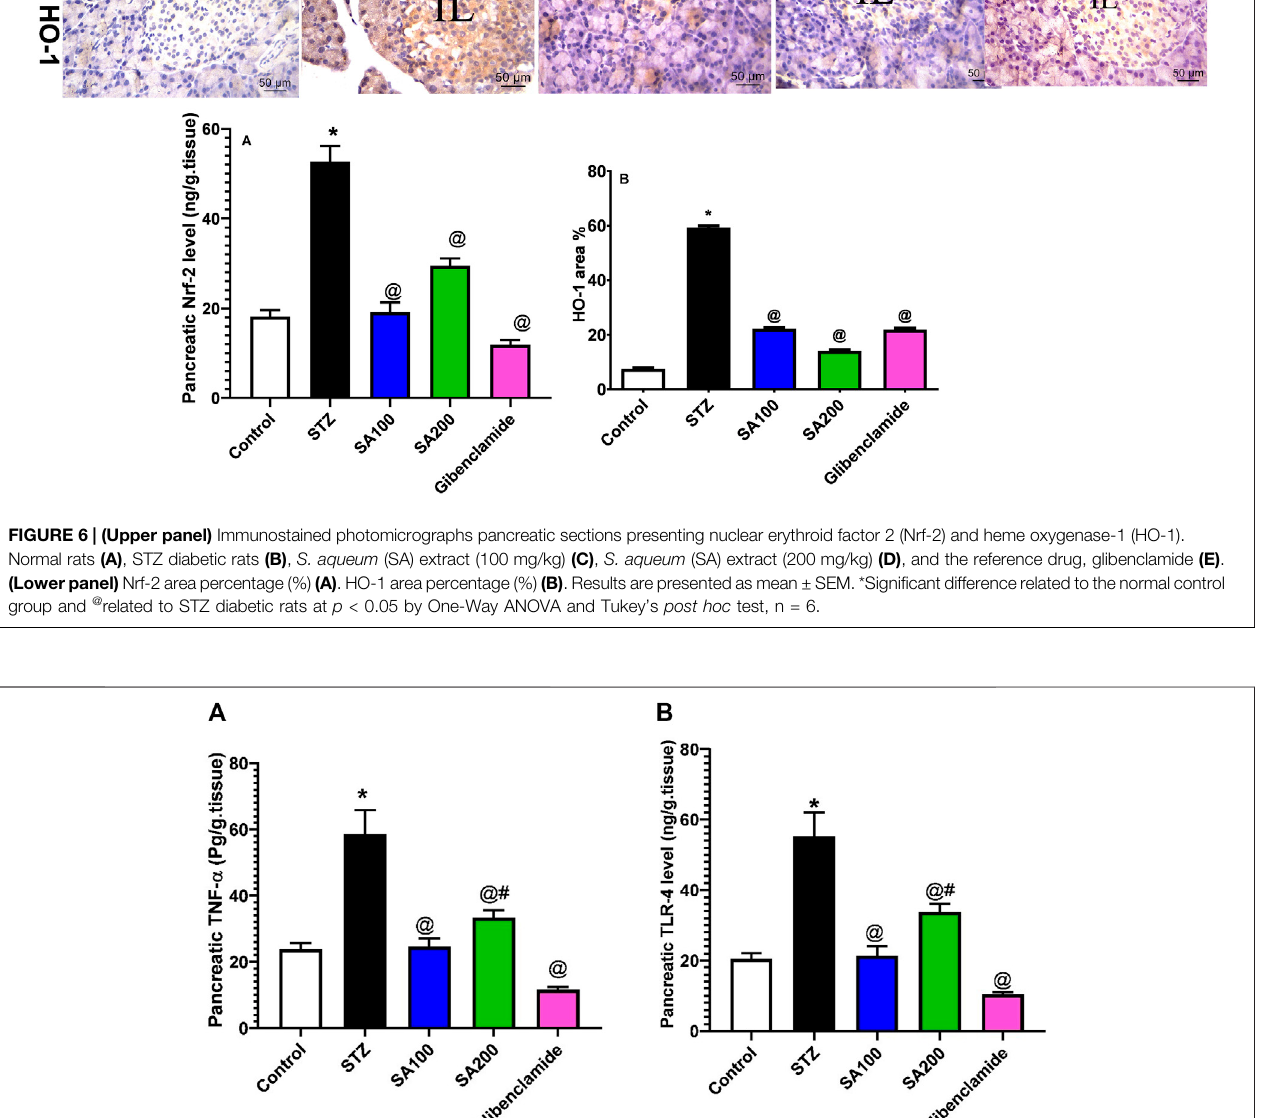
Frontiers in Pharmacology |